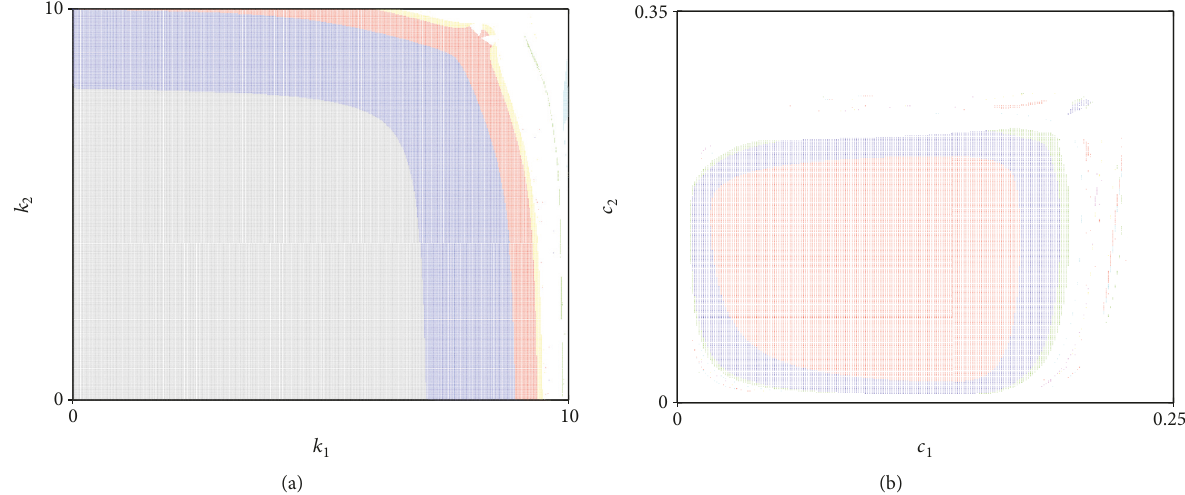
Figure 7: (a) 2D bifurcation diagram in the plane (𝑘 1 , 𝑘 2 ) at 𝑞 0,1 = 0.11 , 𝑞 0,2 = 0.12 , 𝑞 3,0 = 0.13 , 𝑘 3 = 7 , 𝑐 1 = 0.19 , 𝑐 2 = 0.18 , and 𝑐 3 = 0.17 . (b) 2D bifurcation diagram in the plane (𝑐 1 ,𝑐 2 ) at 𝑞 0,1 = 0.11 , 𝑞 0,2 = 0.12 , 𝑞 3,0 = 0.13 , 𝑘 1 = 8.5 , 𝑘 2 = 5 , 𝑘 3 = 7 , and 𝑐 3 = 0.17